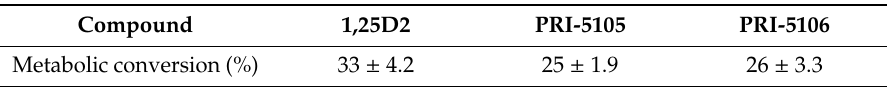
Table 1. Human CYP24A1-dependent metabolic conversion of the 19 -nor VDDs of 1,25D2 (PRI-5105 and PRI-5106) in comparison with their most active metabolite of vitamin D 2 (1,25D2). Metabolic conversion (%) Compound 1,25D2 Data represent the means ± SD of at least three independent experiments.